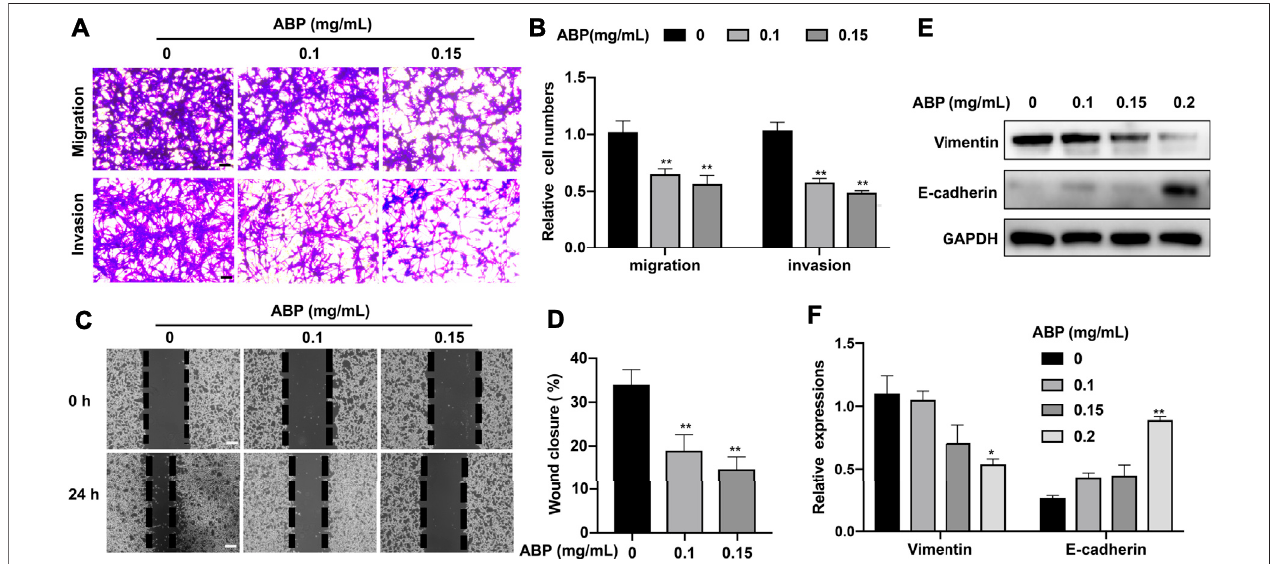
FIGURE 2 | ABP treatment suppresses the migratory and invasive activity of CRC cells. (A-B) Transwell assay examining the negative effect of ABP on the migration and invasion of CT26 cells. Scale bar (cid:2) 50 μ m. (C-D) Wound healing assay examining the negative effect of ABP on the migration and invasion of CT26 cells.